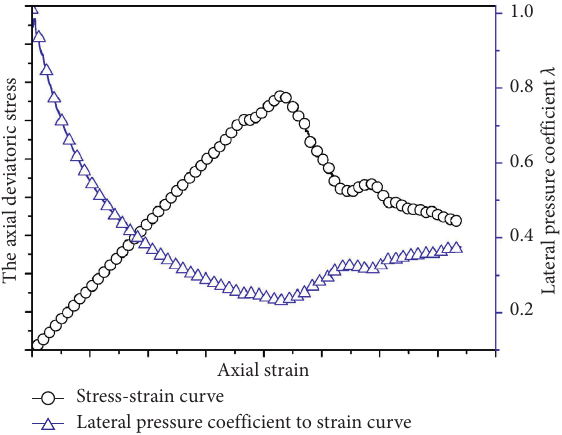
Figure 2: Conceptual axial deviatoric stresses with different λ